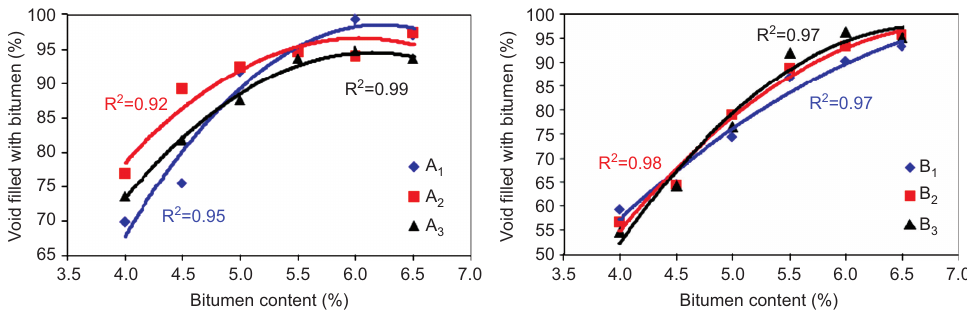
Figure 7 Relation between % bitumen and % void filled with bitumen.